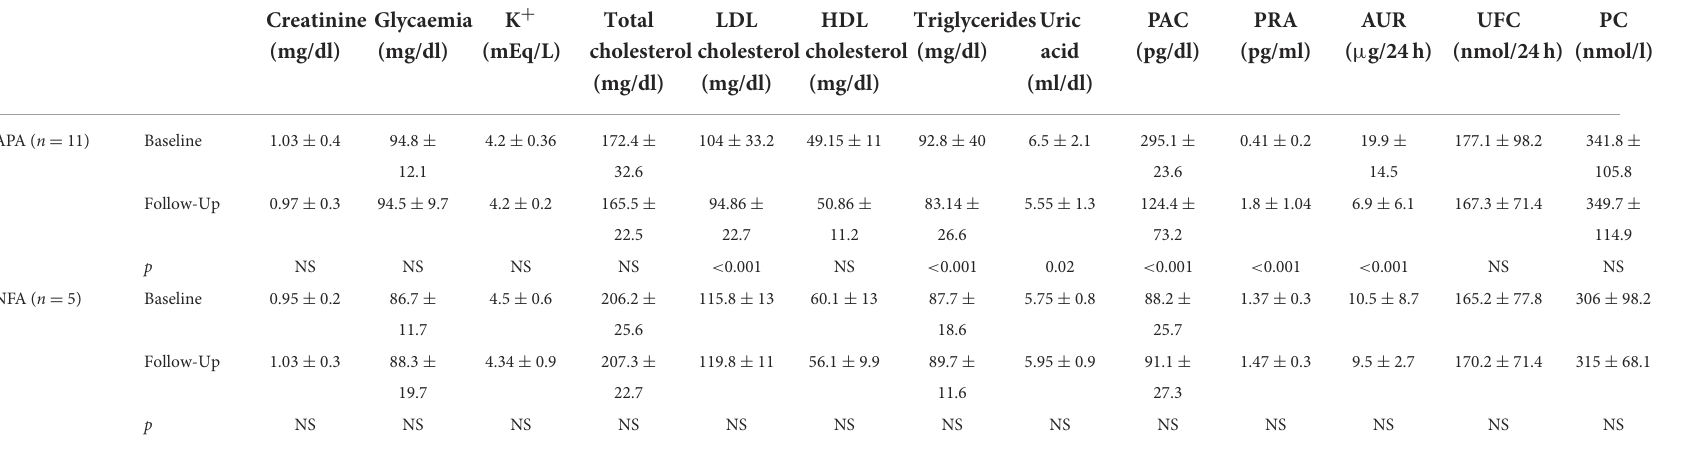
TABLE 2 Biochemical and hormonal data of all patients at baseline compared to